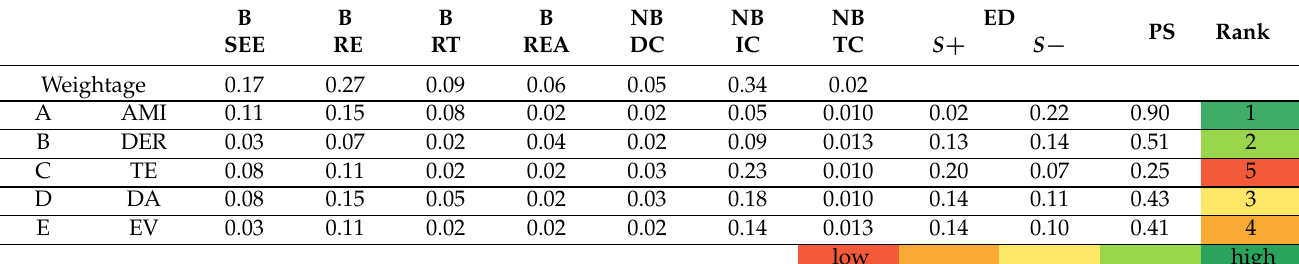
Table 22 shows the MCDM operation with TOPSIS method, and Equations (8) and (9) are used for making the calculations. Table 22. MCDM operation using TOPSIS. B ≡ Beneficial, NB ≡ Non-Beneficial. SEE ≡ System Efficiency Enhancement, RE ≡ Reliability Enhancement, RT ≡ Reduced Theft, REA ≡ Renewable Energy Adoption, DC ≡ Deployment Challenges, IC ≡ Investment Cost, TC ≡ Technological Challenges. The TOPSIS formulae for the normalization: T ( x ij ) normalization = x ij and for the performance score: T ( S i ) score (cid:113) ∑ N i = 1 ( x ij ) 2